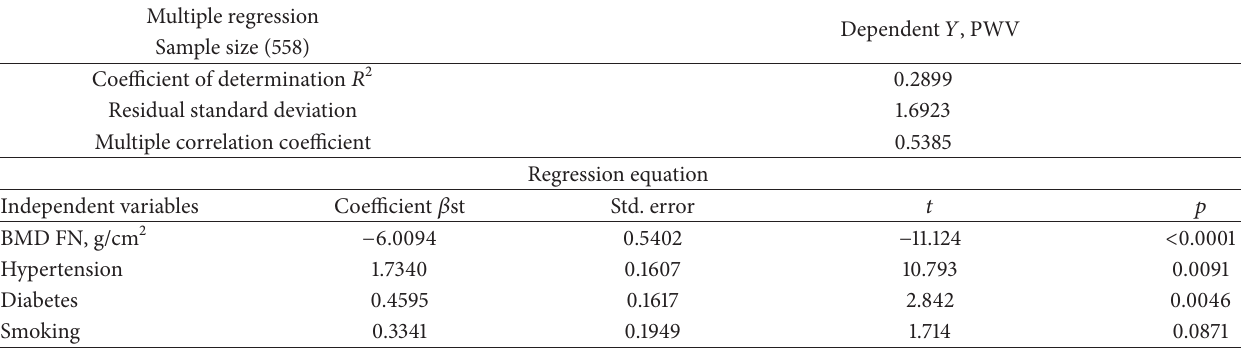
Table 3: Multiple backward regression analysis of determinants of